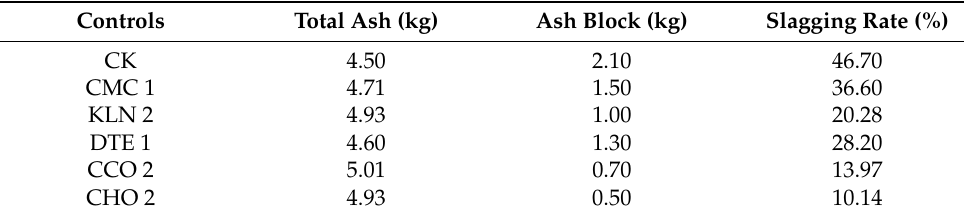
Table 5. Slagging rate of bottom ash under controlled